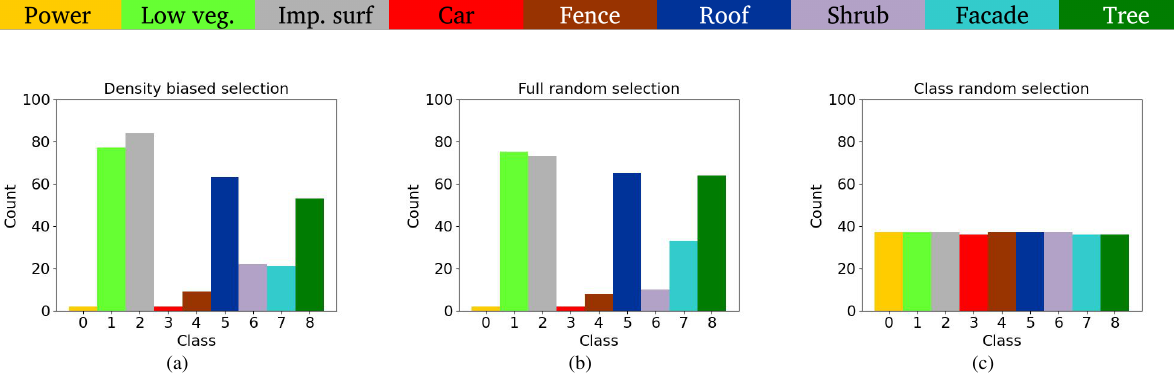
Figure 3. Comparison of class distribution of weak-label